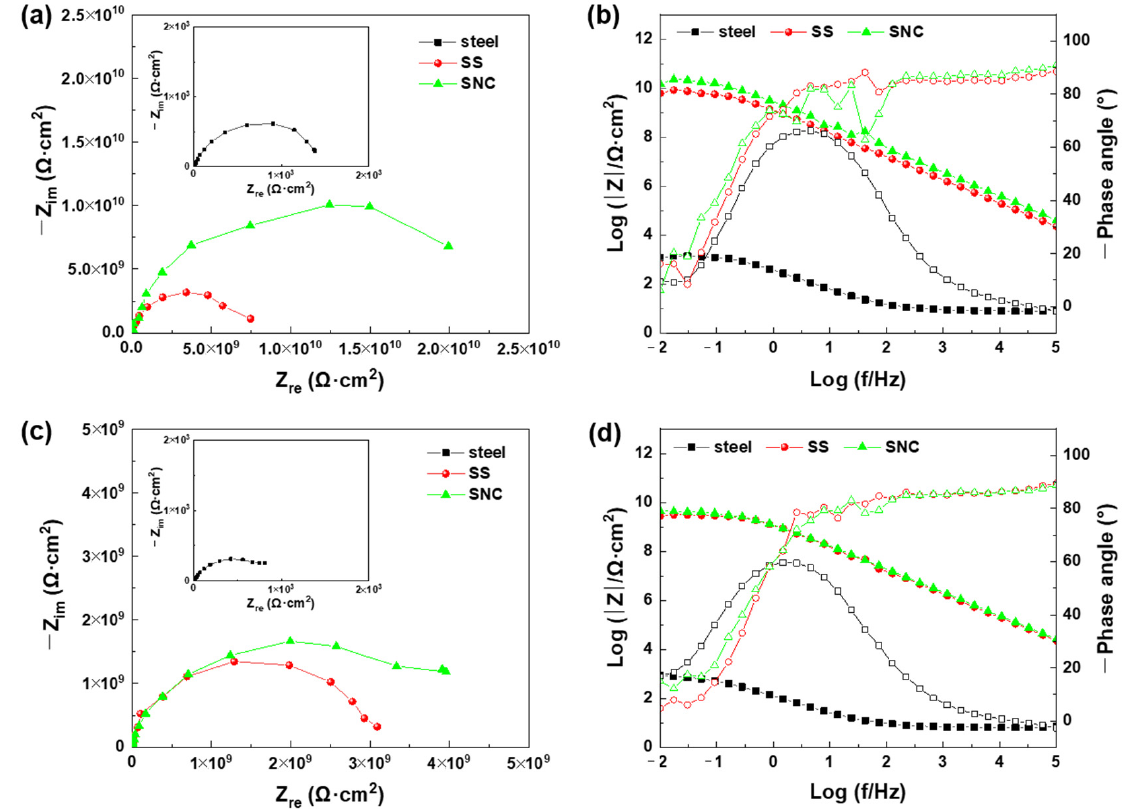
Figure 8. EIS results of the samples after ( a , b ) 1 day and ( c , d ) 3 days of immersion in 3.5% NaCl solution.